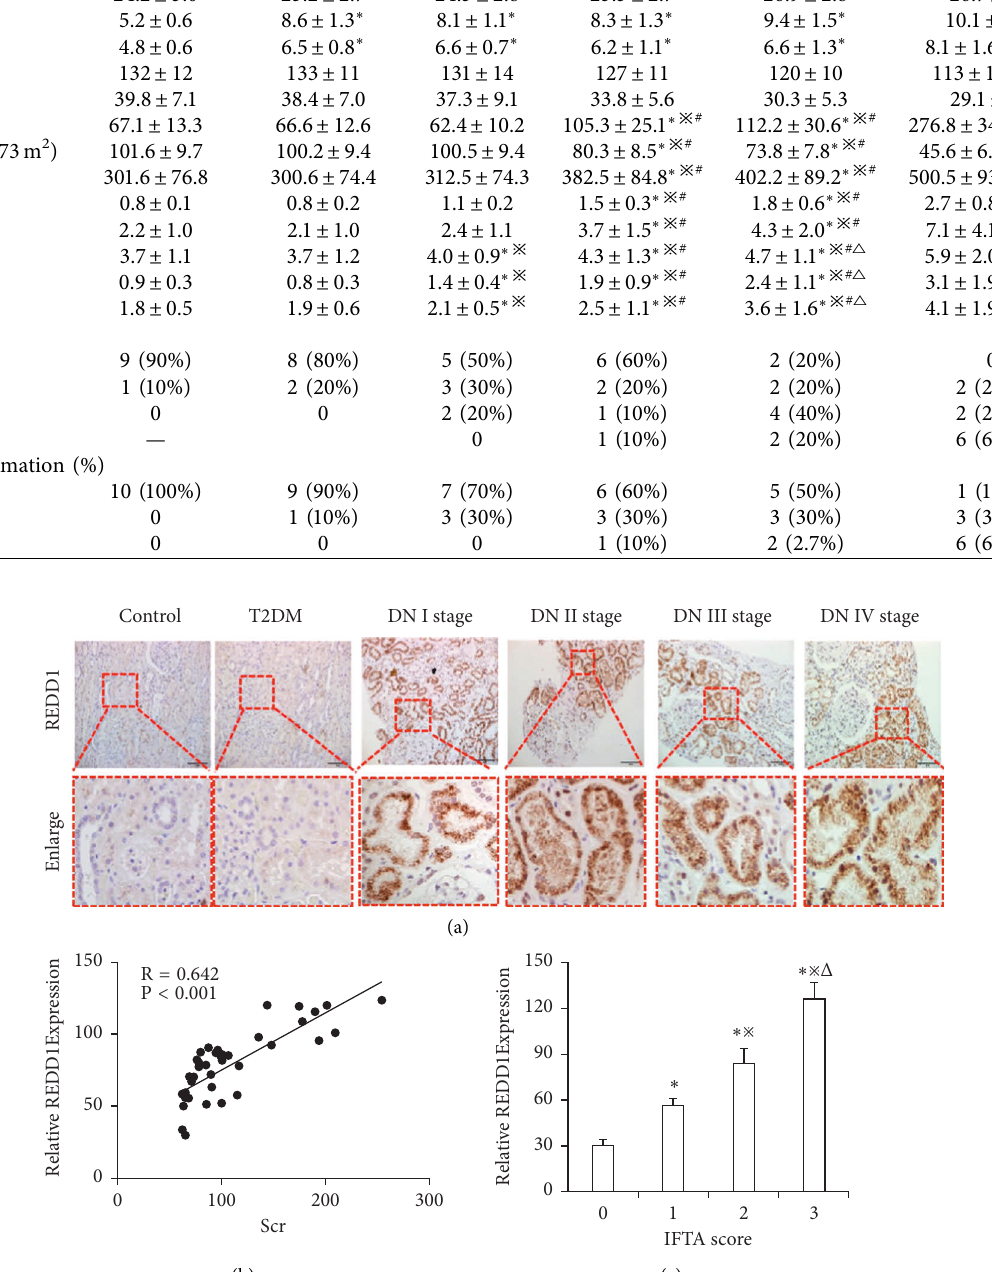
Table 1: General characteristics of the control, diabetes, and DN groups. n blood glucose; HbA1c: glycosylated hemoglobin; Hb: hemoglobin; Alb: serum albumin; Scr: serum creatinine; eGFR: estimated glomerular filtration rate; β 2MG: β 2-microglobulin; UA: uric acid; TC: total cholesterol; TG: total triglyceride; LDL: low-density lipoprotein; BMI: body